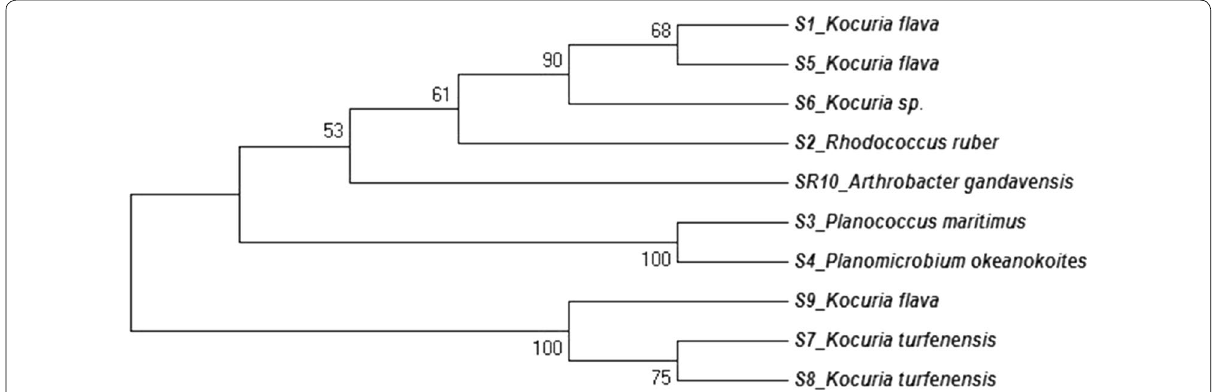
Fig. 2 Phylogenetic tree of identified strains positive for zeaxanthin